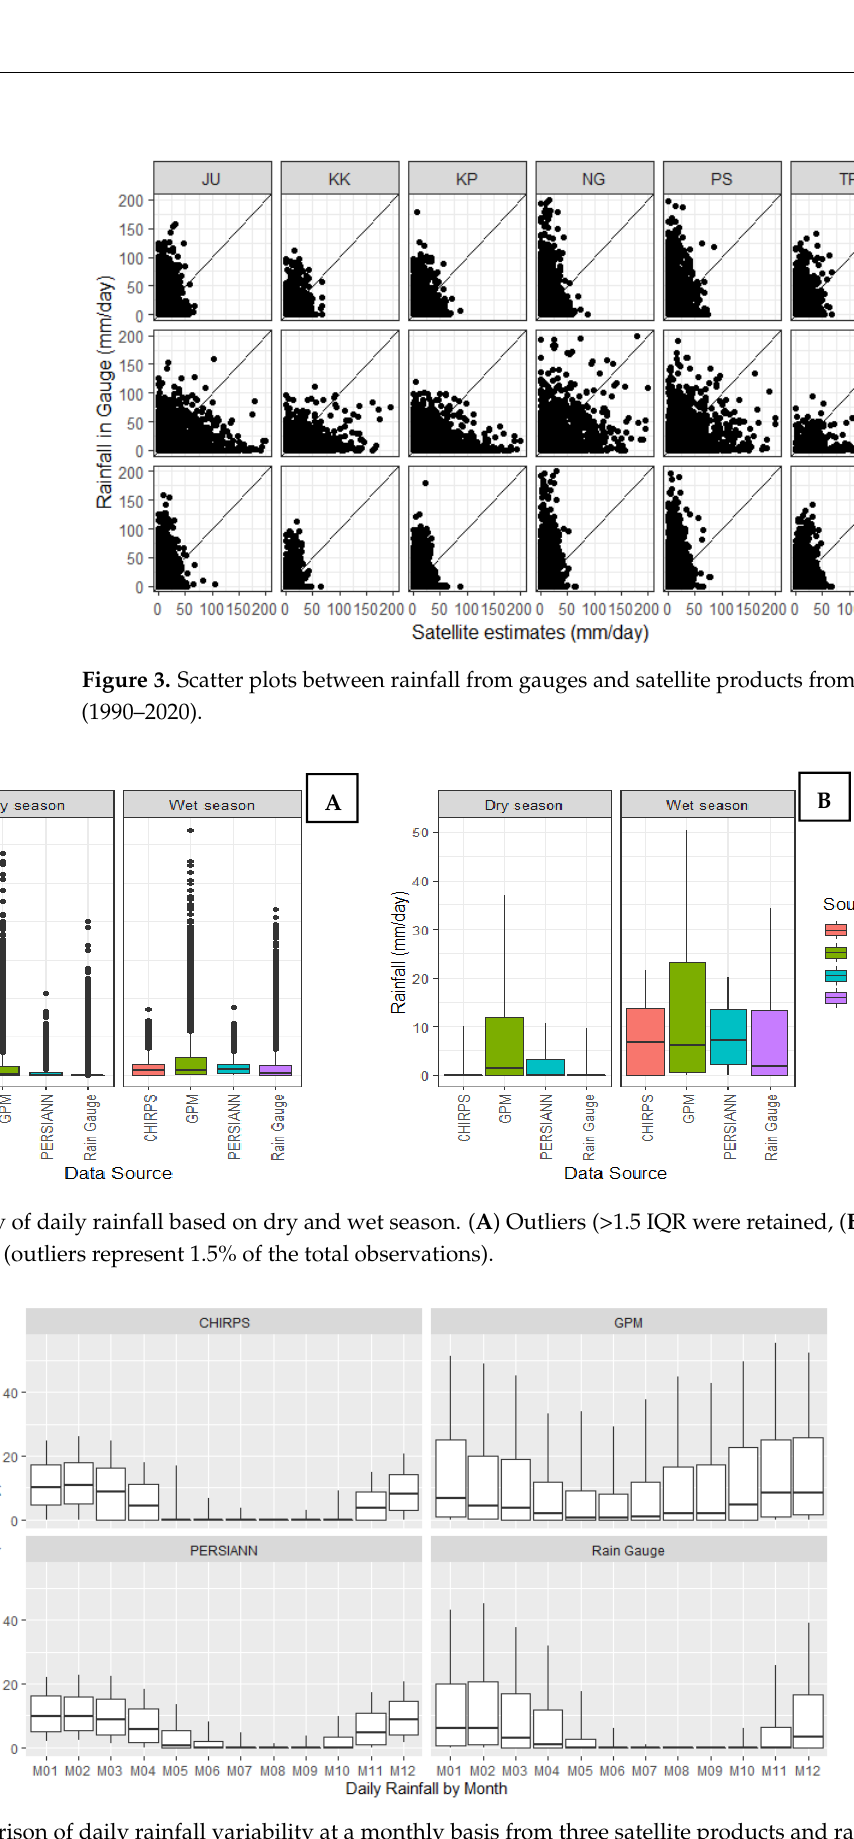
Figure 5. Comparison of daily rainfall variability at a monthly basis from three satellite products and rainfall gauges.